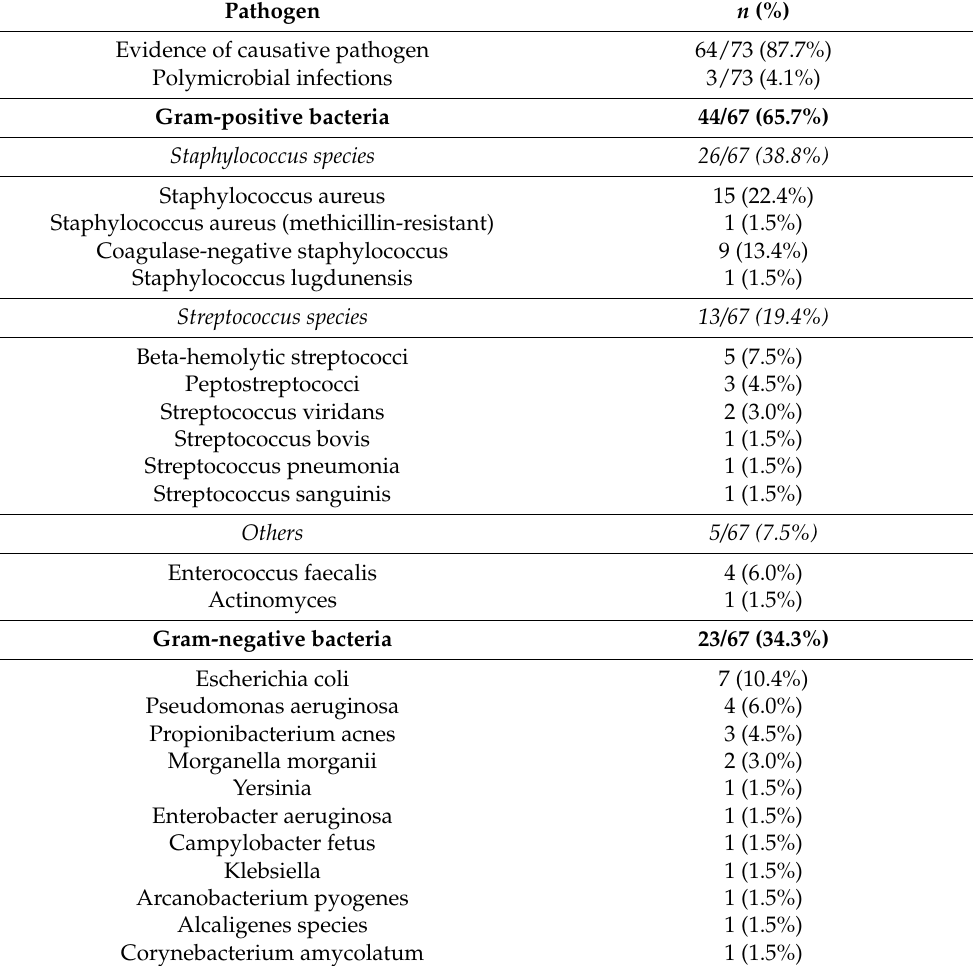
Table 3. Microbiology results.